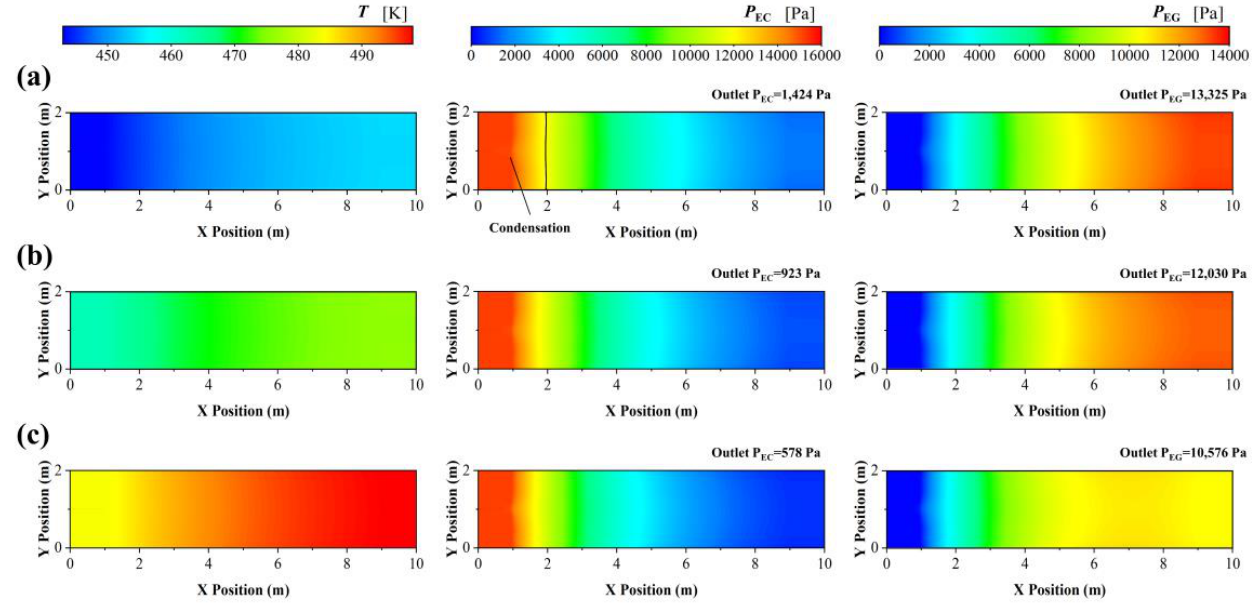
Figure 4. Contours of T , P EC and P EG in the adiabatic reactor with different reactant inlet temperatures of ( a ) 443 K, ( b ) 463 K and ( c ) 483 K under the conditions of 3 MPa, 0.3 g EC · gcat − 1 · h − 1 and H 2 /EC = 200.